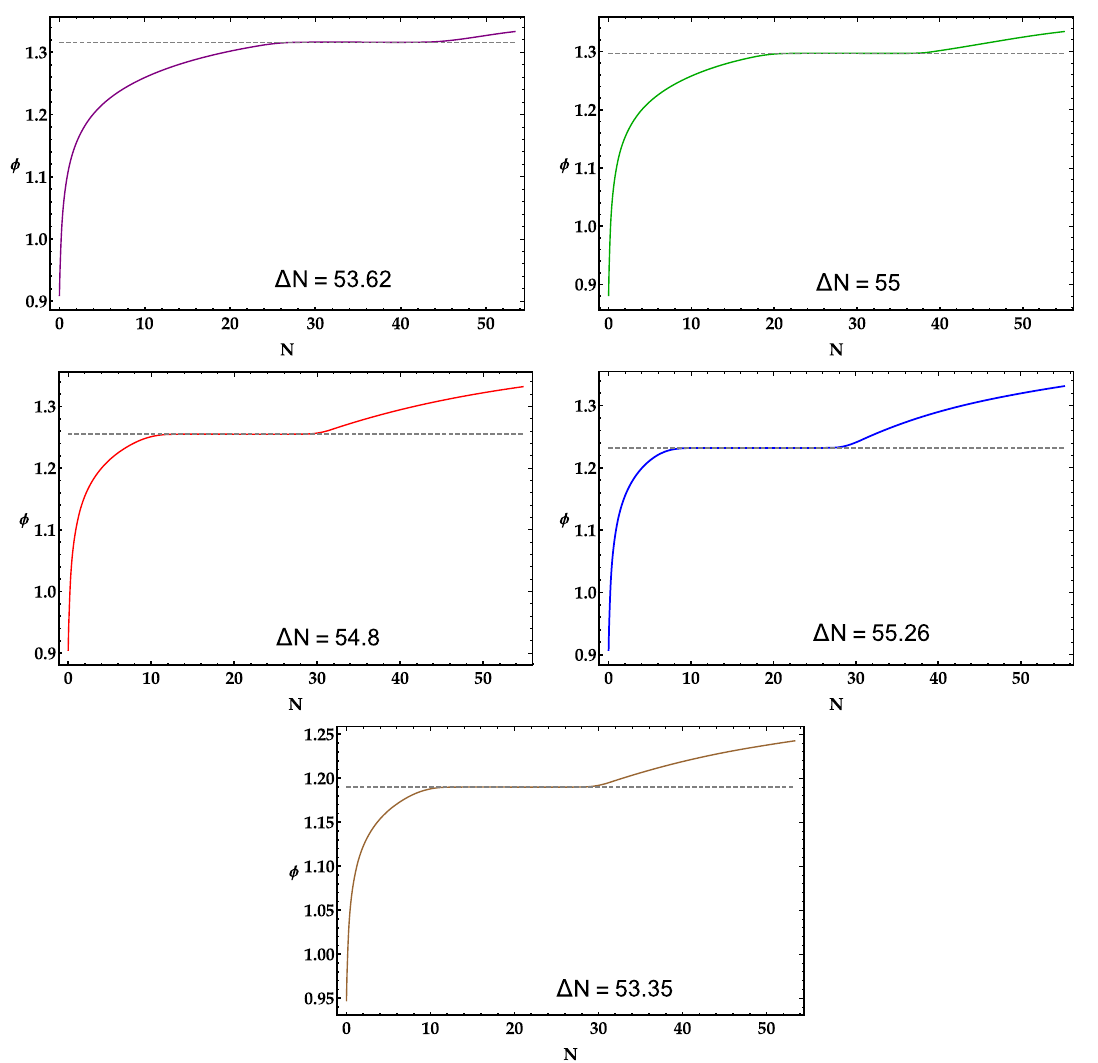
Fig. 1 Evolution of the scalar field φ as a function of e -fold number N for Case A (purple line), Case B (green line), Case C (red line), Case D (blue line), and Case F (brown line). The dashed lines show φ = φ c for each Case and the initial conditions are found by using Eqs. (11) and